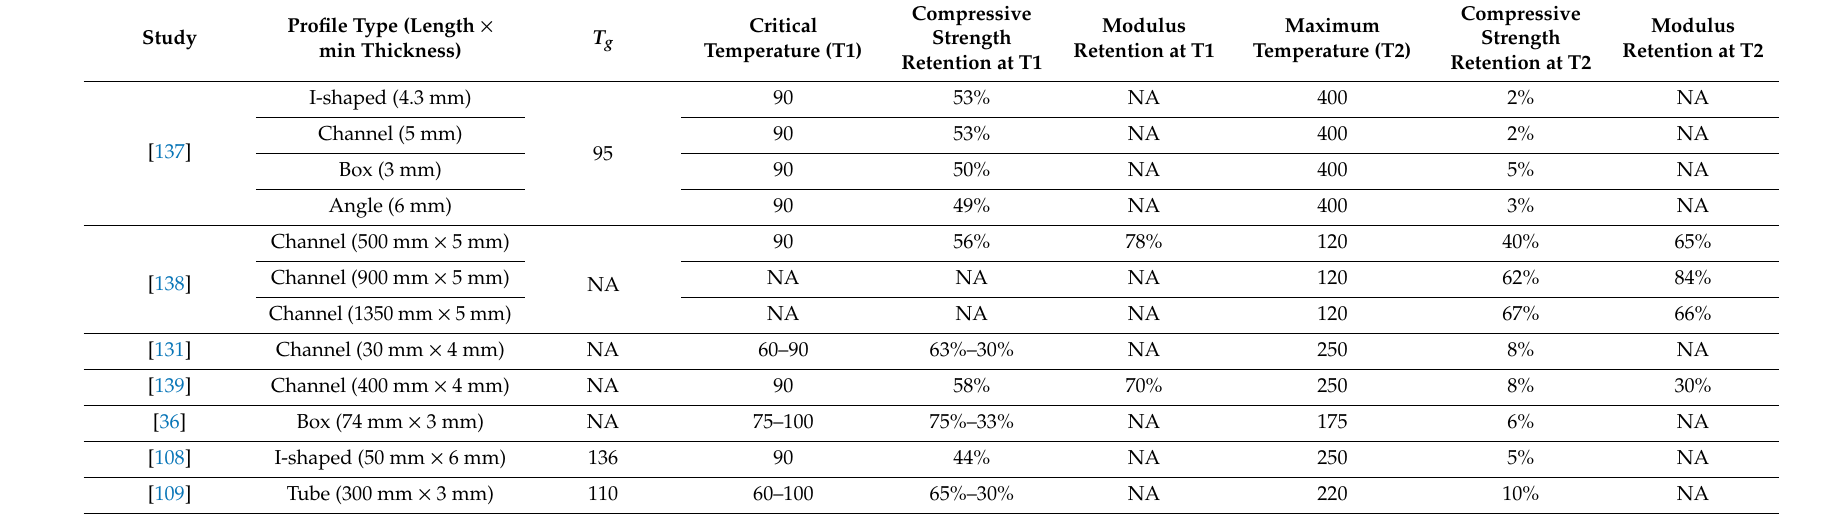
Table 7. Pultruded GFRP (polyester resin) profiles compressive properties after exposure to elevated